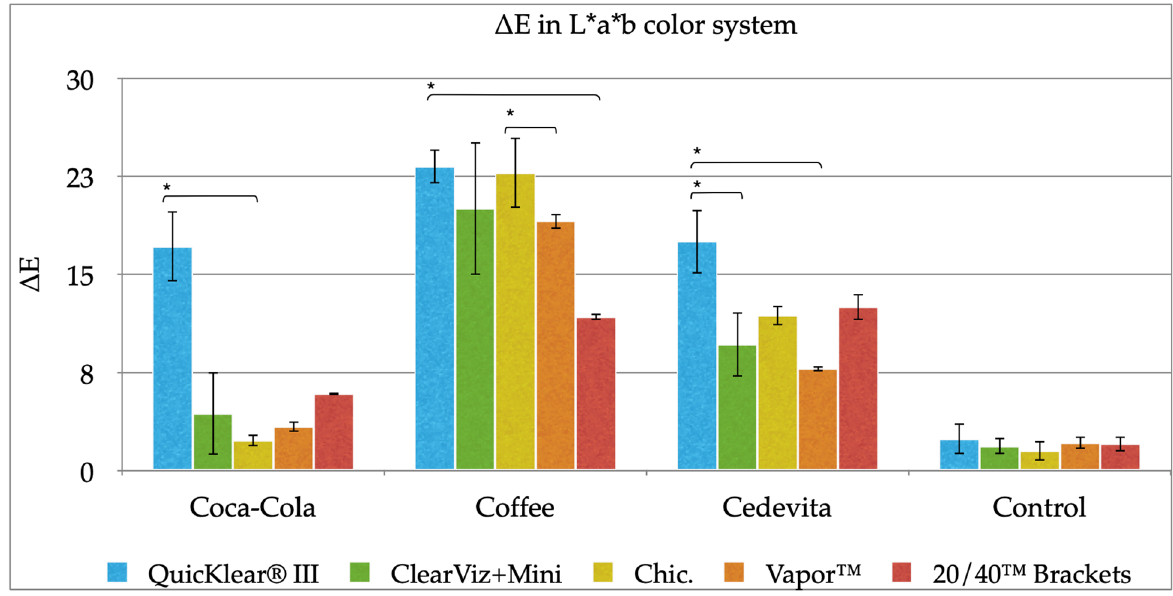
Figure 1. Color change values ( Δ E*) of ceramic brackets after 14 days of immersion. * statistically significant difference p < 0.05. Table 2. Means and standard deviations of color change values ( Δ E*) of ceramic brackets, according to the solution over time.